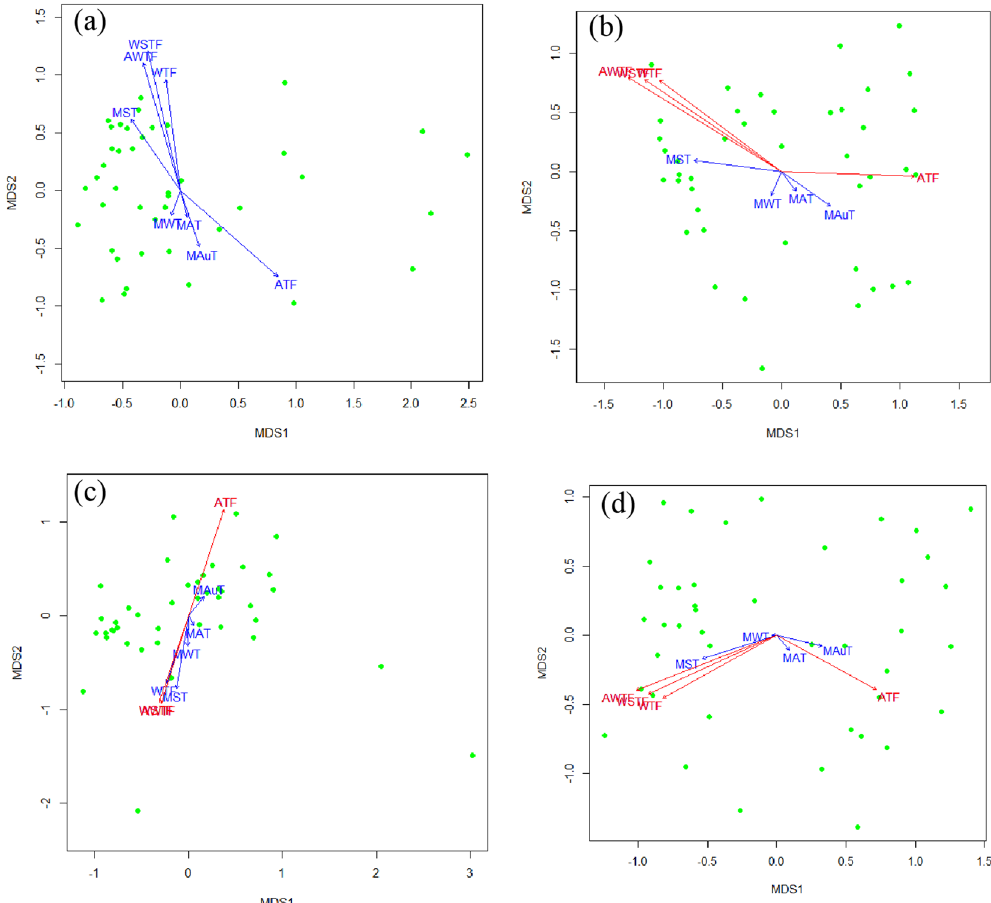
Figure 3. Temperature factors in ordination for ( a ) D ′ pw, ( b ) D ′ nn, ( c ) Trait D ′ pw and ( d ) Trait D ′ nn, respectively. Green points indicate wintering waterbird communities. Red arrows indicate significantly factors (p < 0.05) associated with a given measure, respectively. Blue arrows indicate factors associated with non- significant measures (p > 0.05),